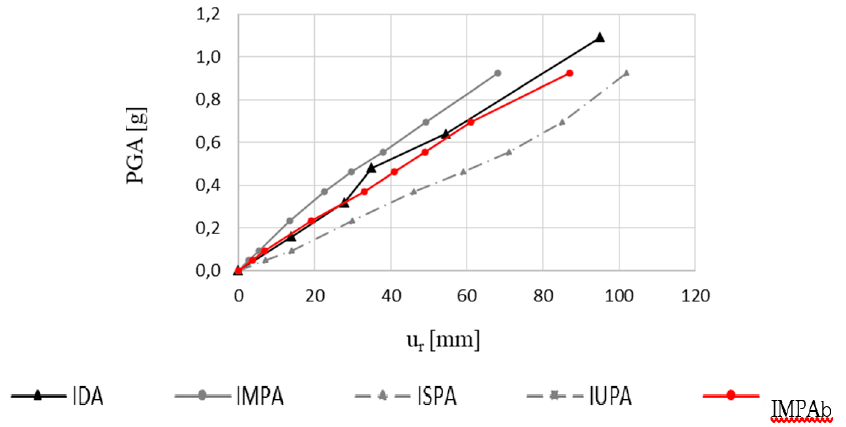
Figure 18. Comparison of the incremental curve and capacity curves obtained according to different procedures (monitoring point displacement (P1) Vs seismic intensity).